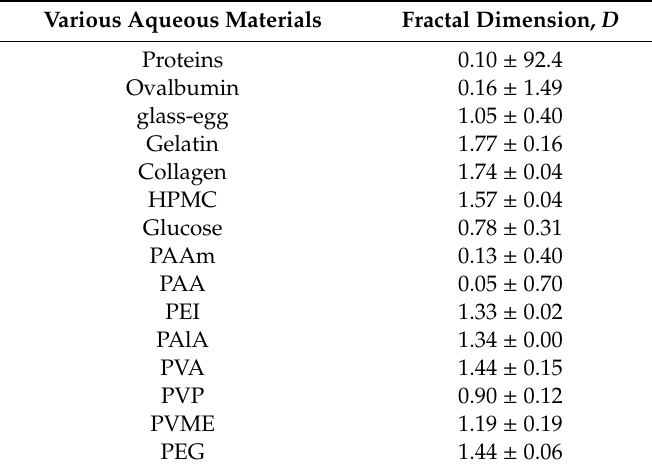
Table 1. Fractal dimension for various aqueous systems.